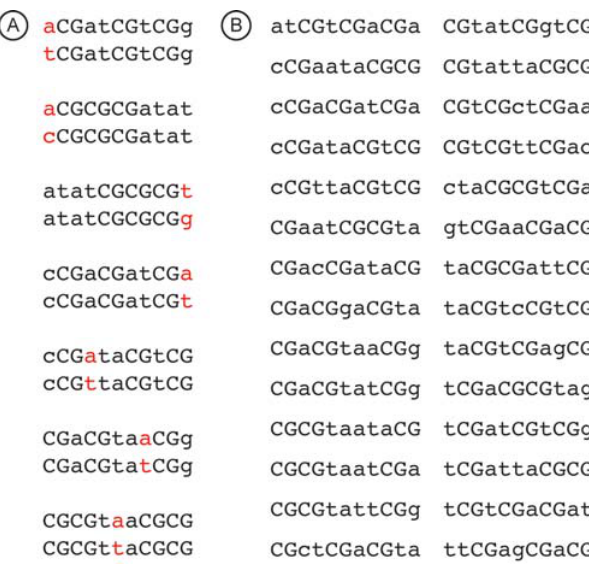
Figure 2. Similarities and differences in human and chimpanzee nullomers. (A) Seven pairs of human nullomers that differ in only one nucleotide. Note that several nullomers are listed twice in ref. 1, as some sequences are reverse complement of others (e.g., atatCGCGCGt and aCGCGCGatat). (B) Set of nullomers that are found in both human and chimpanzee genomes (data from http://trac.boisestate.edu/dna/ap- plets/SeqCount.html) [1].